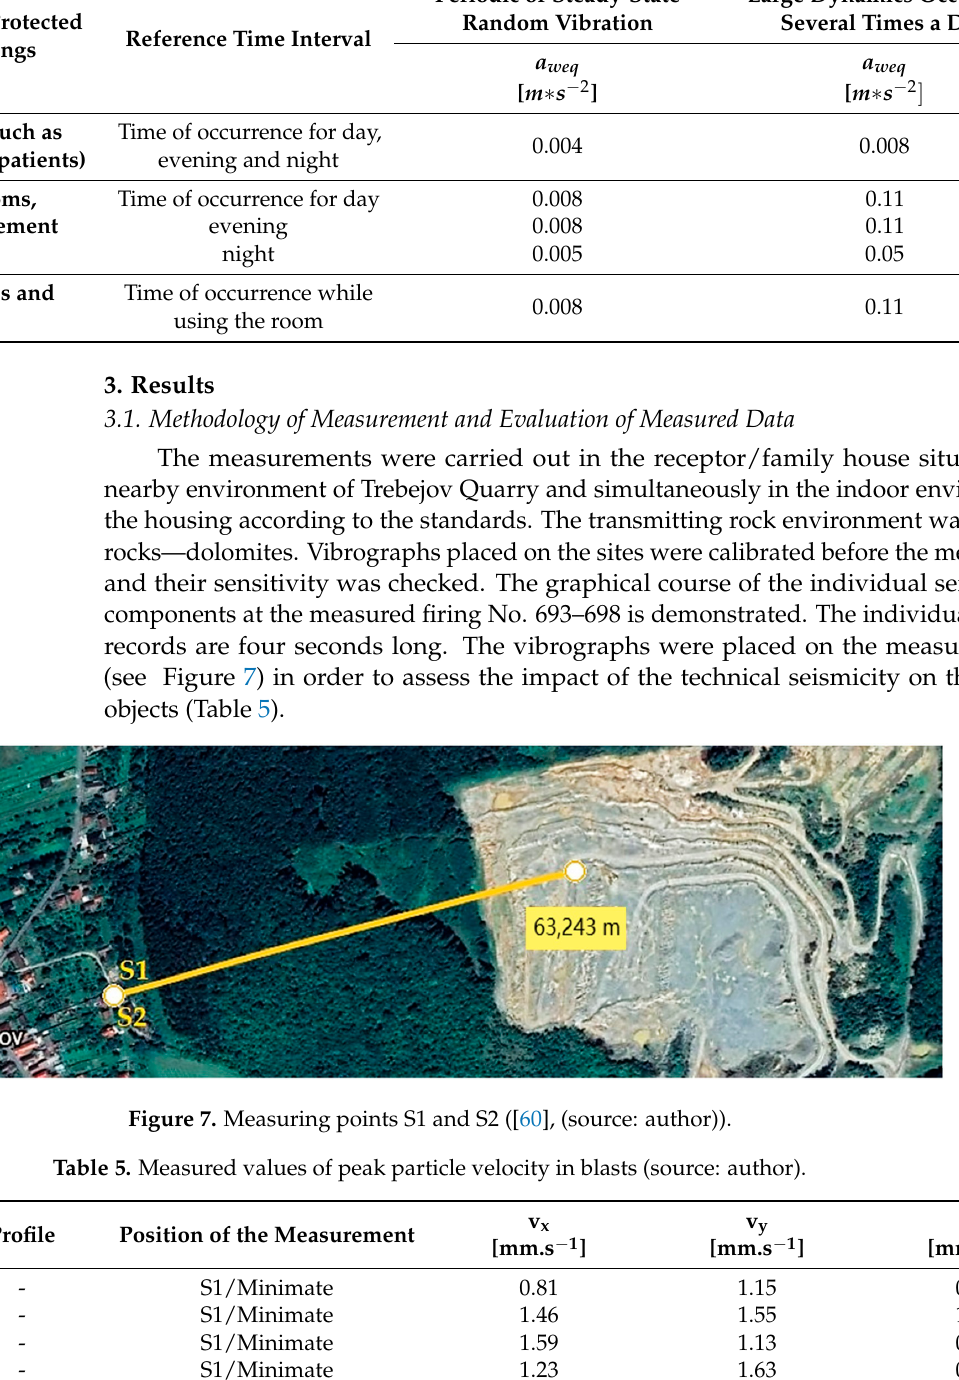
Table 5. Measured values of peak particle velocity in blasts (source: author)